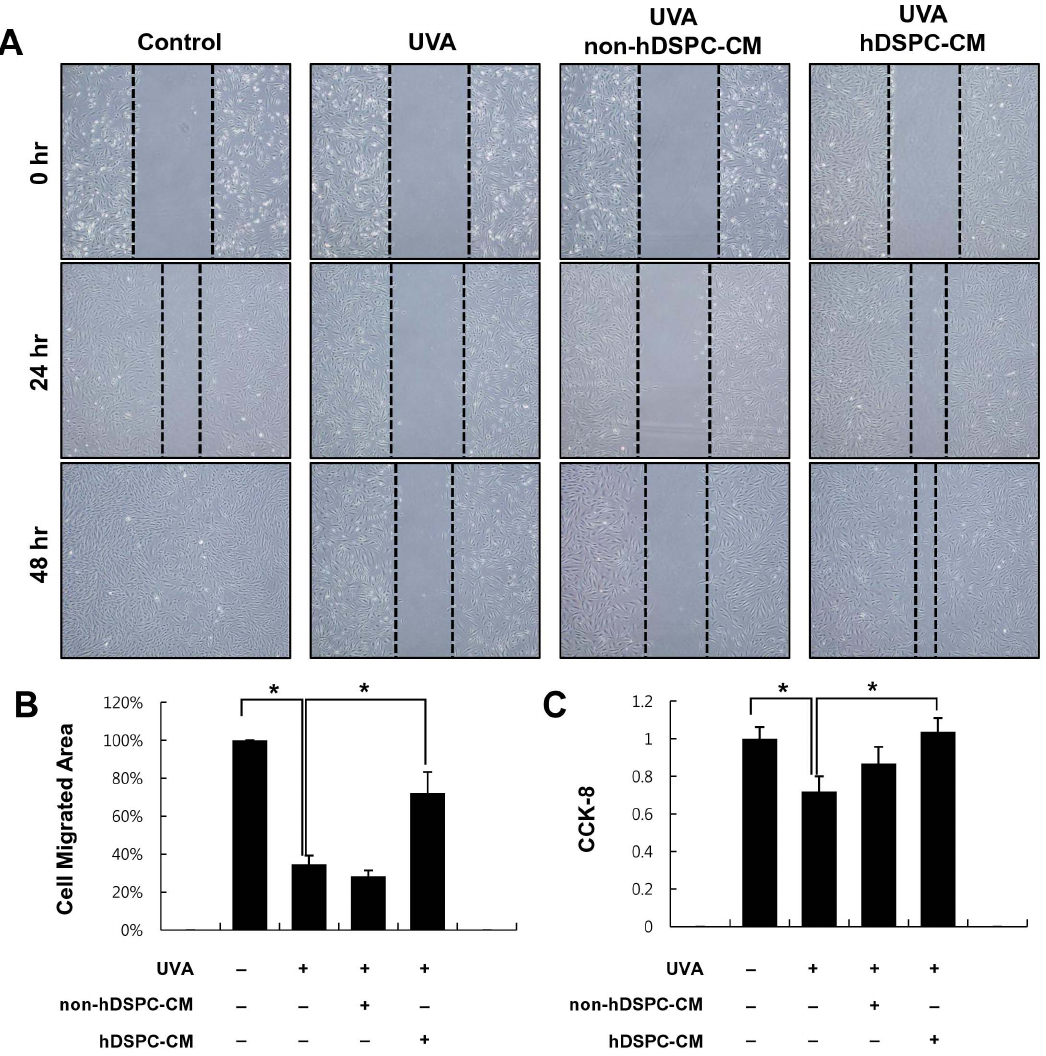
Figure 3. hDSPC-CM promoted the migration and proliferation of UVA-irradiated NHDFs. Effects of hDSPC-CM on NHDF migration. Scratch wound healing assays were performed using conditioned media and UVA-irradiated NHDFs for 48 hr. Images were obtained at 0, 24, and 48 hr (A). Quantitative analysis of the scratch wound healing assay after 48 hr (B). The proliferation of the NHDFs was examined in the presence or absence of hDSPC-CM or non-hDSPC-CM. CCK-8 assay was performed at 48 hr (C). The graphs are shown as the mean 6 S.D. of three